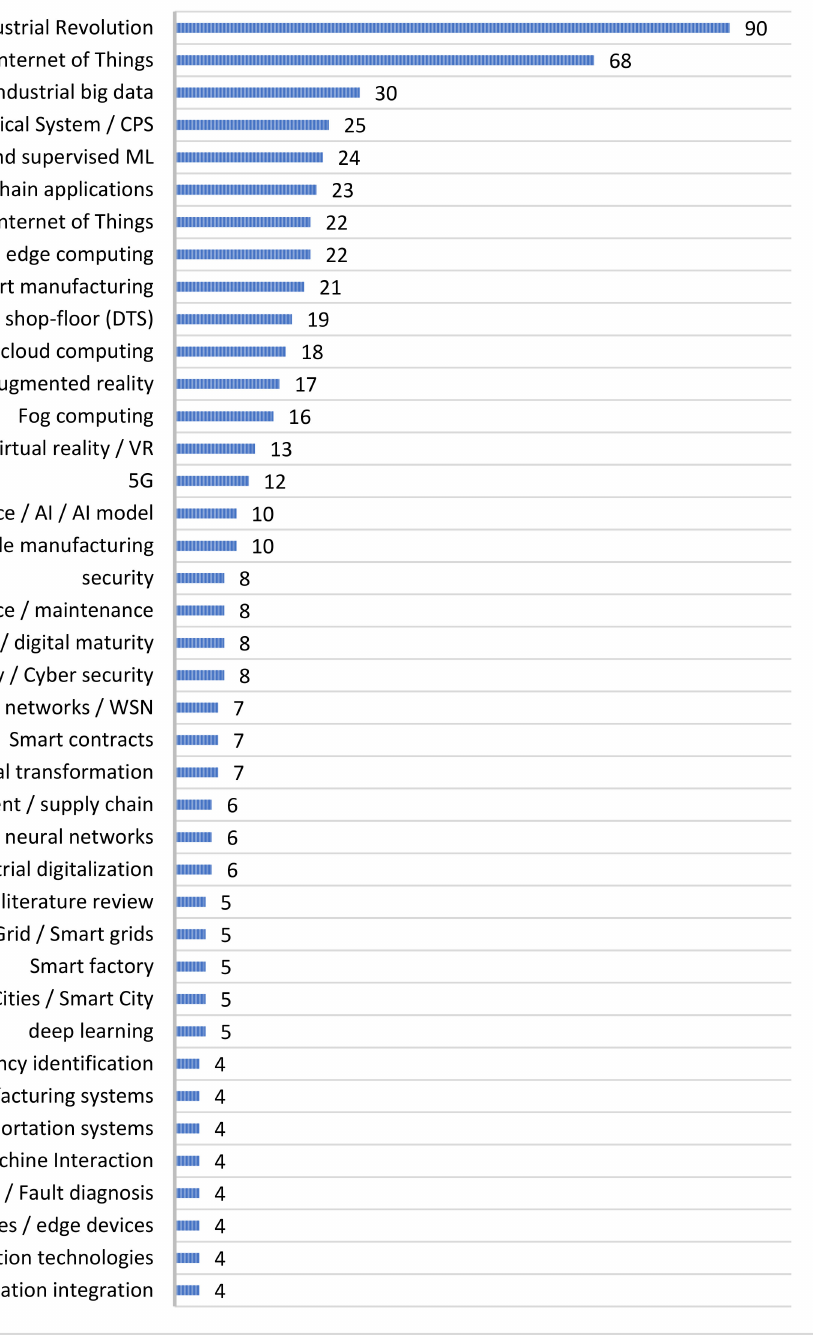
Figure 7. Keywords most frequently